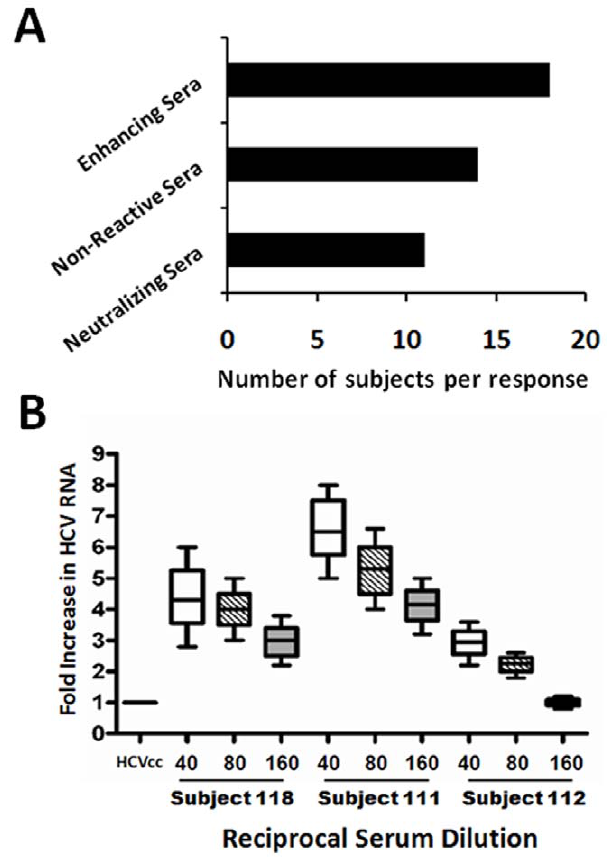
Figure 1. Screening for cell culture grown HCV genotype 1a (clone H77) infectivity in the presence of vaccine sera. The bar diagrams represent the overall outcome of the vaccinee sera to interfere with virus infectivity. Enhancing sera are defined as those which display a . 2 fold increase in FFU, while not displaying neutralization at dilutions between 1:10 and 1:160. Neutralizing sera are those which display $ 50% decrease in FFU at a dilution of $ 1:20 (panel A). Enhancement of cell culture grown HCV genotype 1a infectivity using serial dilutions of selected vaccinee sera are shown (panel B). Fold increase in real-time PCR values of HCV RNA with three representative sera at different dilutions, and a decrease in HCV RNA in response to a different vaccinee serum are